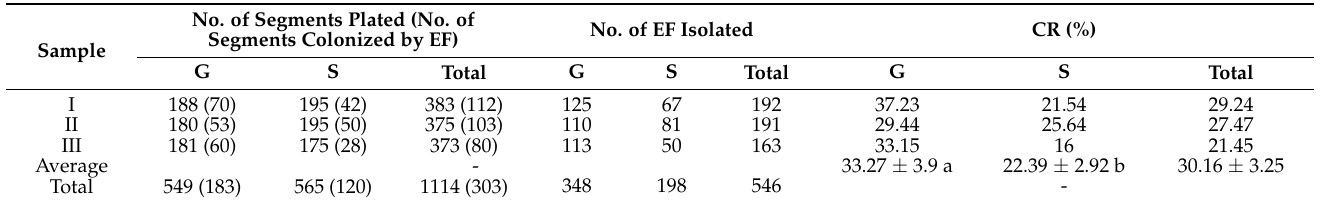
Table 2. The number and colonization rate (CR) of culture-dependent endophytic fungi (EF) of S. chamaejasme .